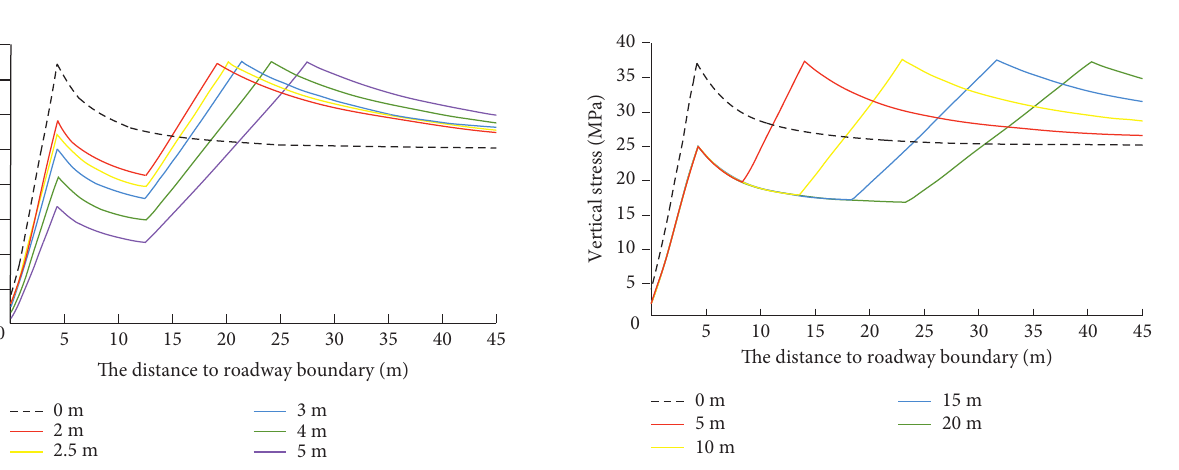
Figure 6: Vertical stress redistribution of roadway sidewall under different water injection fracturing radius.